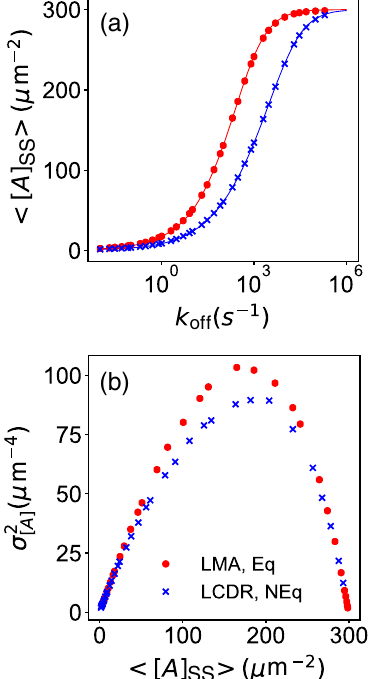
FIG. 5. Suppression of noise in dimerization reaction: (a) The i as a mean steady-state concentration of the monomers h½ A (cid:2) SS function of the dissociation rate of the dimer k . To compare the off ¼ κ ¼ 4 μ m 2 s − 1 for the LMA with LCDR, we assume that k 0 on LMA because then k is identical in both equilibrium and off nonequilibrium simulations. The simulation results [see legend in (b)] match exactly with the analytically calculated values (lines). (b) The variance of i . The variance is identical monomer concentrations, σ 2 ½ vs h A (cid:2) SS A (cid:2) between the LMA and LCDR at chemical equilibrium (LCDR not shown). However, in nonequilibrium steady states, the variance is i at lower for the LCDR than for the LMA for the same h½ A (cid:2) SS intermediate concentrations. For both simulations, we use i ≈ 150 μ m − 2 , beyond which the finite- Fig. 5 until h½ A (cid:2) SS ness of the system becomes important.